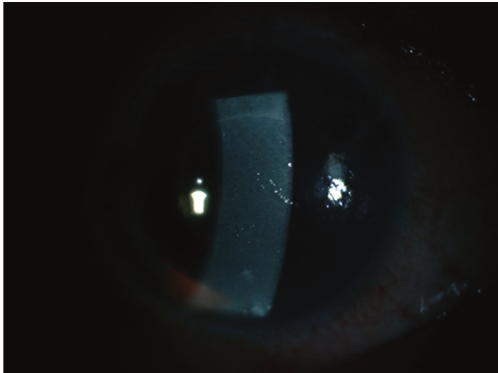
Figure 3: Broad slit lamb photograph showing clear slightly decen- tered corneal graft, the aniridia optical zone area surrounded by a black diaphragm of the aniridia